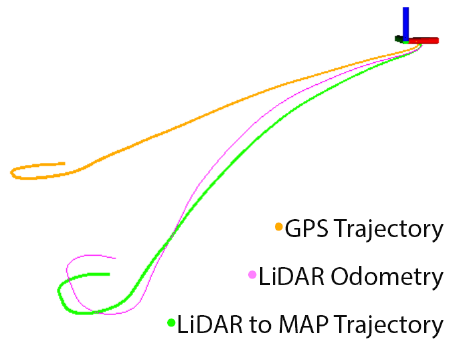
Figure 3. Trajectory from LOAM (Dataset 01 from KITTI VO/SLAM